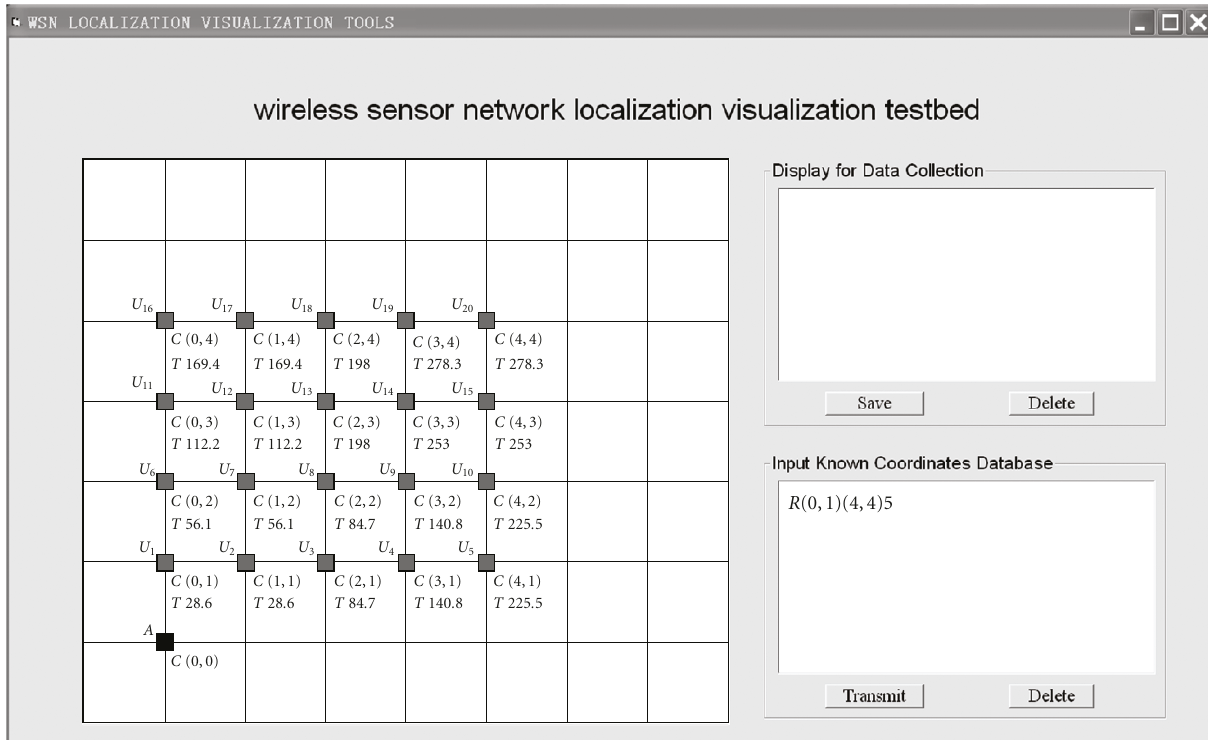
Figure 13: The software interface of localization visualization.